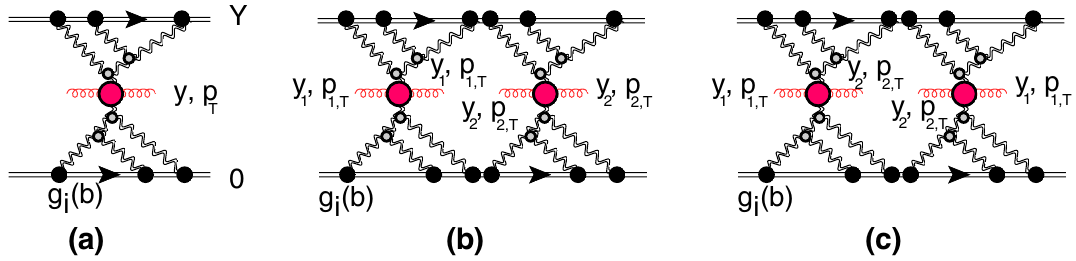
Fig. 3 The generic Mueller diagrams [142] for single inclusive ( a ) and for double inclusive ( b , c ) production. b Double inclusive cross section, c interference diagram for the Bose–Einstein correlation. For ease of drawing we take y 1 = y 2